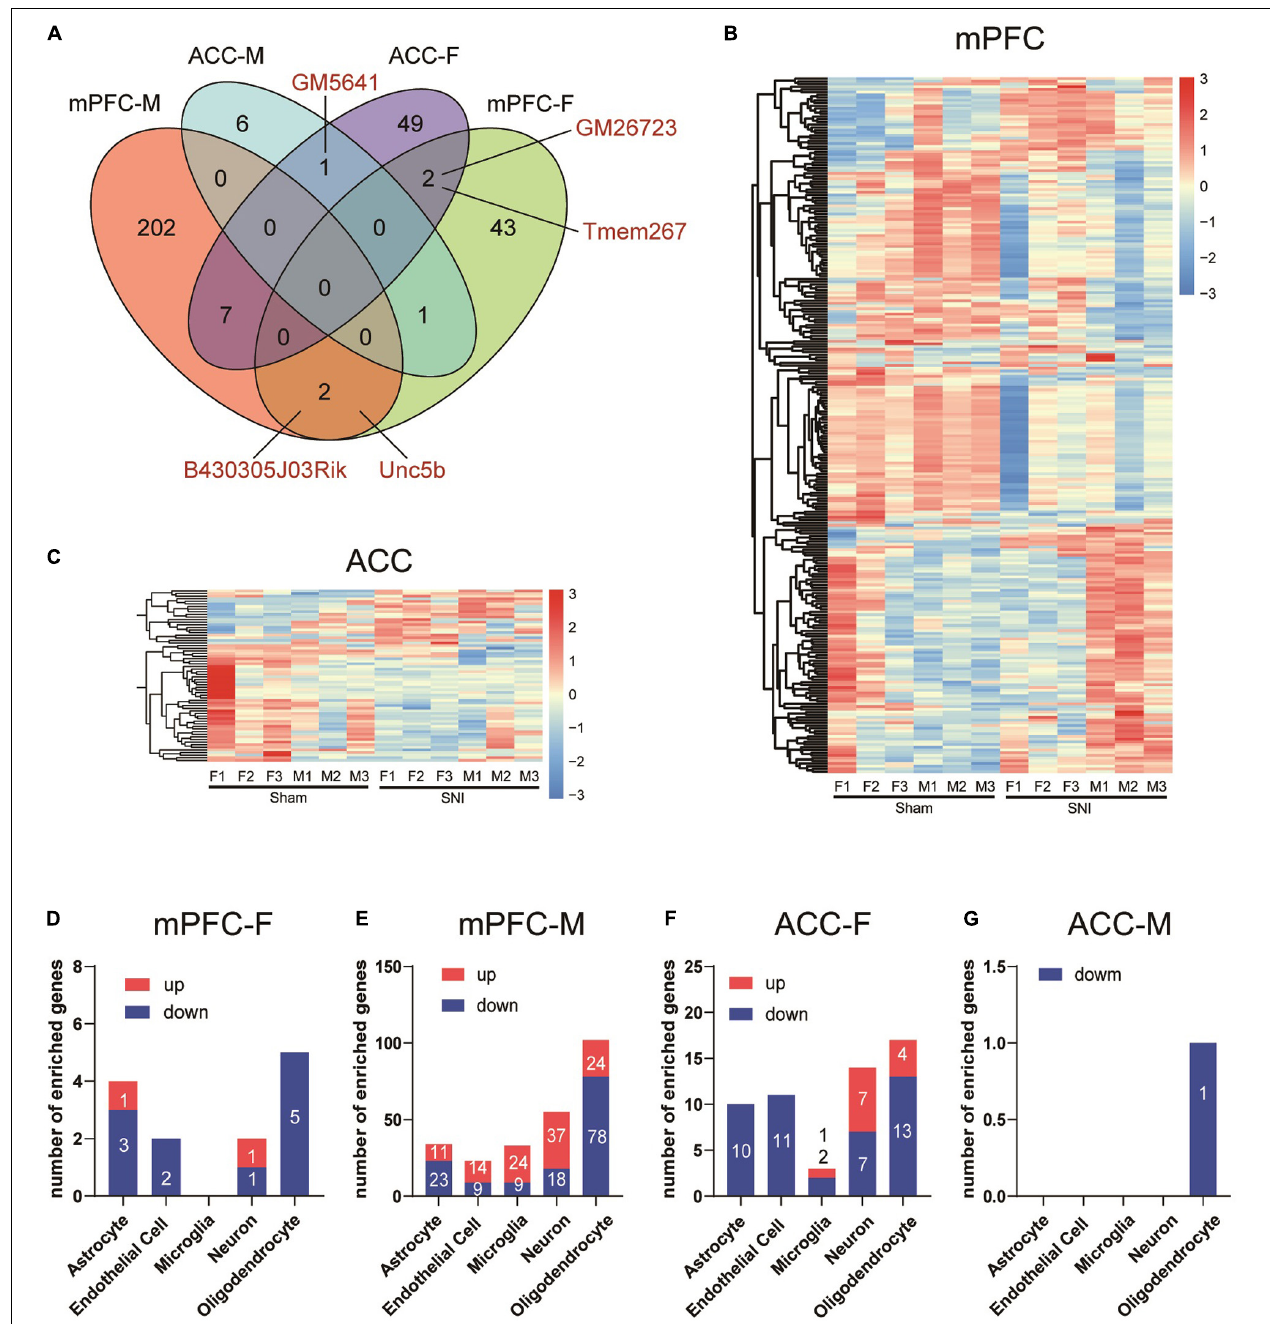
FIGURE 3 | Differential transcriptomic profiles and cell-type enrichment of the DEGs induced in the mPFC and the ACC of mice of different sexes by SNI. (A) Venn diagram depicting limited overlaps of the DEGs between the mPFC and the ACC, as well as between different sexes. mPFC-F, the mPFC of female mice; mPFC-M, the mPFC of male mice; ACC-F, the ACC of female mice; ACC-M, the ACC of male mice. Hierarchical clustered heatmaps of the mPFC (B) and the ACC (C) , showing relative expression of the DEGs across the sham and the SNI groups in different sexes (F, female; M, male). Color scales represent standardized rlog-transformed values across samples. (D–G) The numbers of DEGs enriched in different cell types in the mPFC and the ACC of female and male mice, comparing the sham versus the SNI groups, as determined from a database of cell type-specific transcripts in the mouse cortex by Zhang et al. (2014).